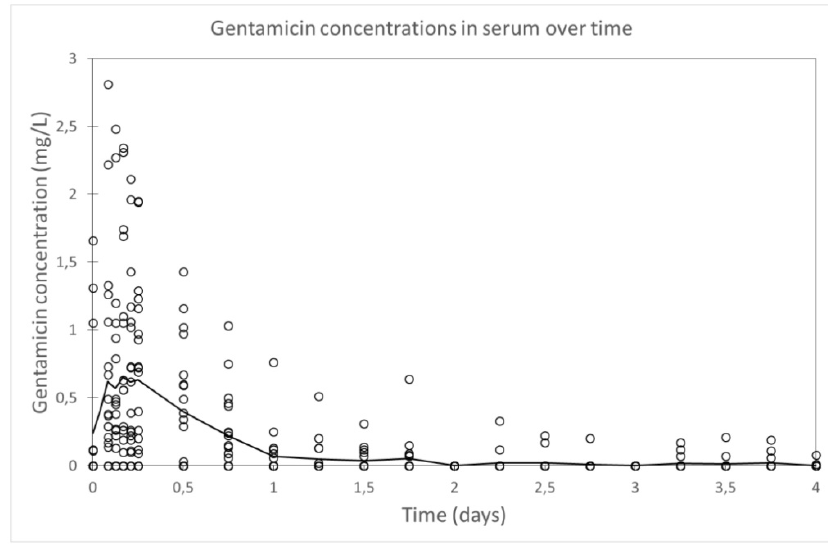
Figure 1: Gentamicin concentrations measured in serum. Every ○ represents one